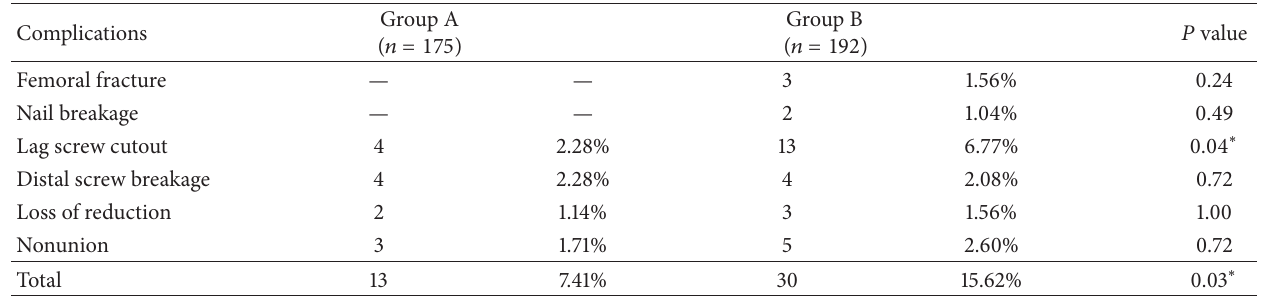
Table 3: Postoperative complications.